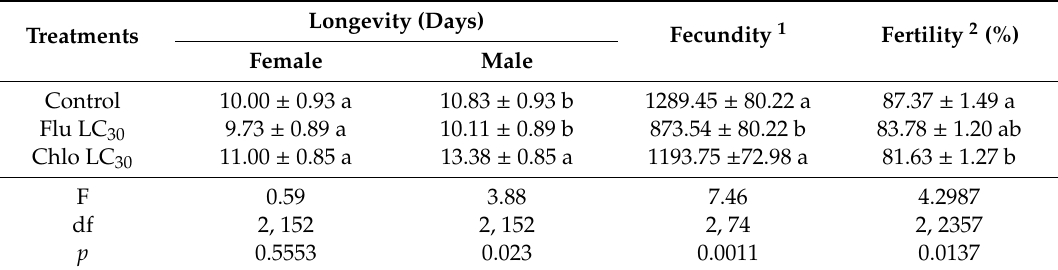
Table 5. Sublethal e ff ects of flubendiamide (Flu) and chlorantraniliprole (Chlo) on adult longevity, fecundity, and fertility of Chloridea virescens under controlled laboratory environmental conditions (25 ± 2 ◦ C, 60 ± 10% RH, and 14L: